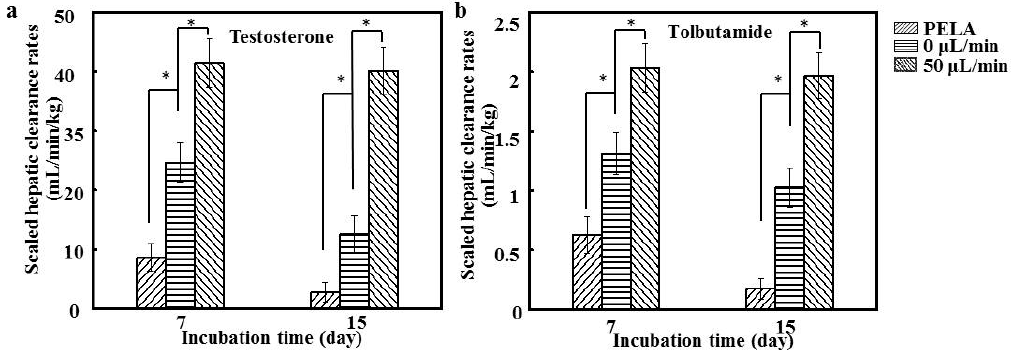
Figure 7. ( a ) The in vitro scaled clearance rates of tolbutamide and ( b ) testosterone during 2 h of metabolism by hepatocytes after 7 and 15 days ( n = 5, * p < 0.05).